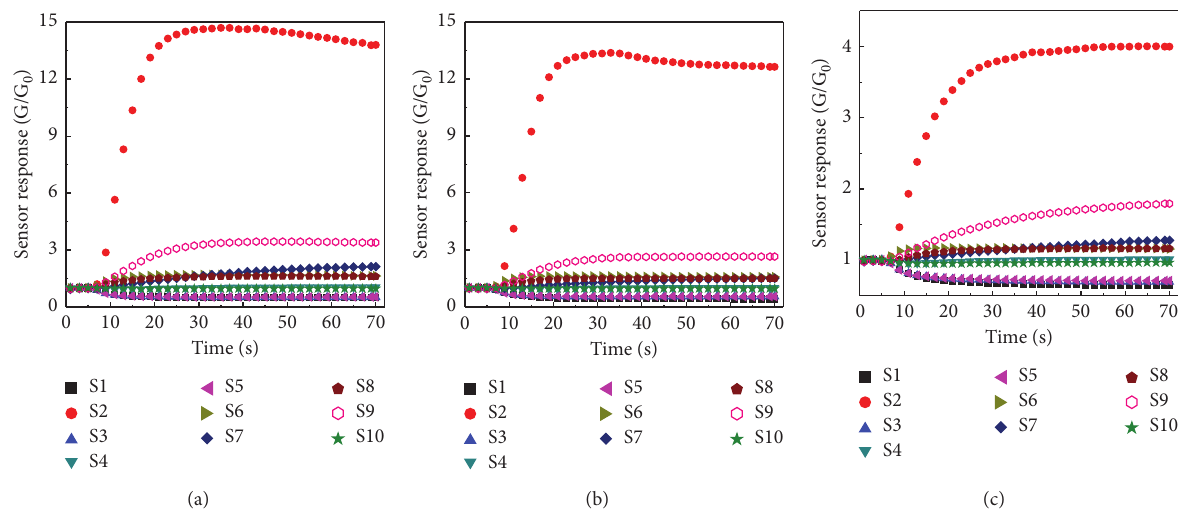
Figure 1: Ten sensors’ response curve to the dried Lycium fruits samples with different producing